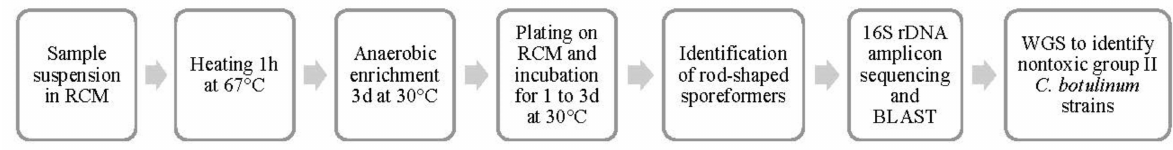
Figure 1. Overview of the isolation procedure for nontoxic nonproteolytic C. botulinum